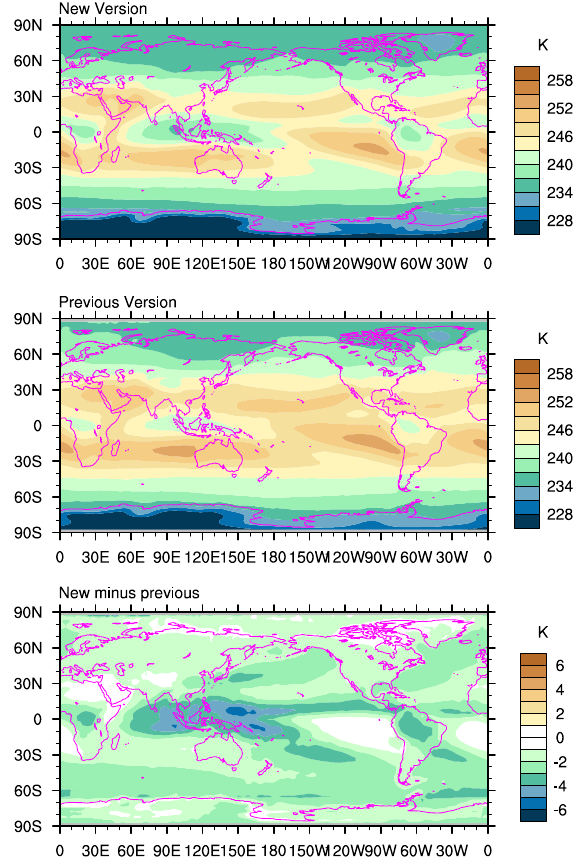
Fig. 3. The 33yr (1979–2011) HIRS channel 12 T B climatology maps for the new version (top panel) and the previous column-clear- sky version of Shi and Bates (2011) (middle panel). The bottom panel shows the difference between the two